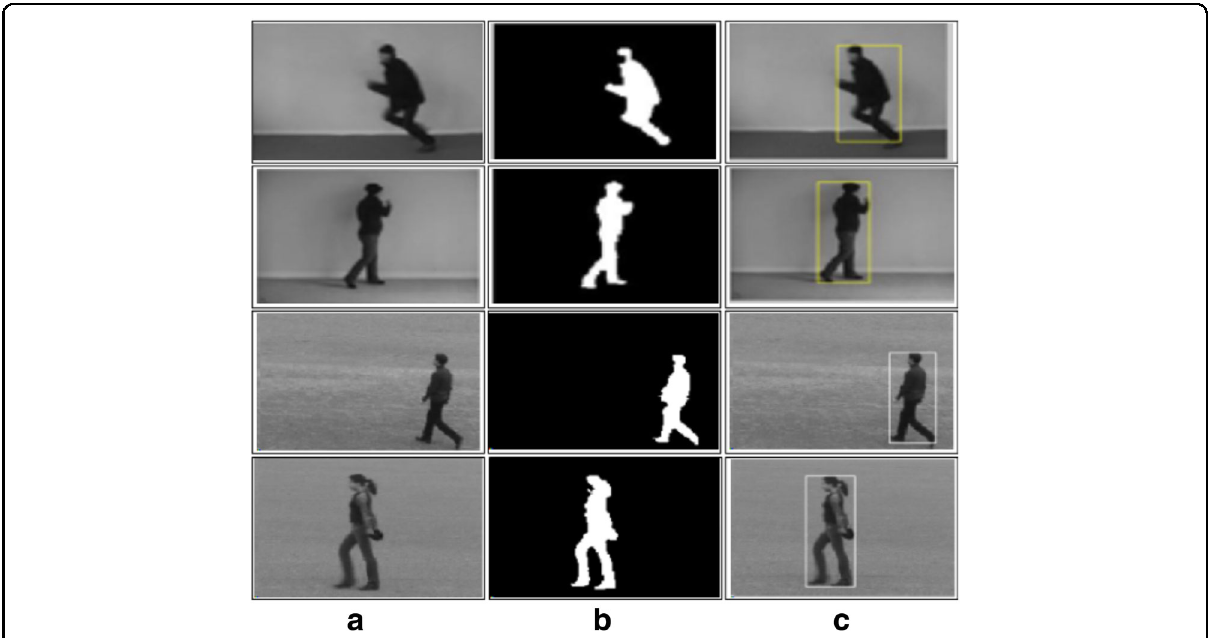
Fig. 5 Frames fusion results. a Original. b Fused frame. c ROI